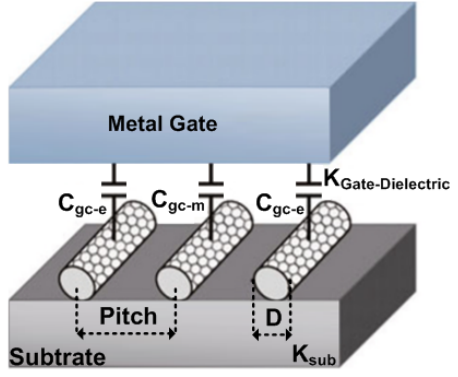
Figure 2. CNFET gate to channel capacitance.